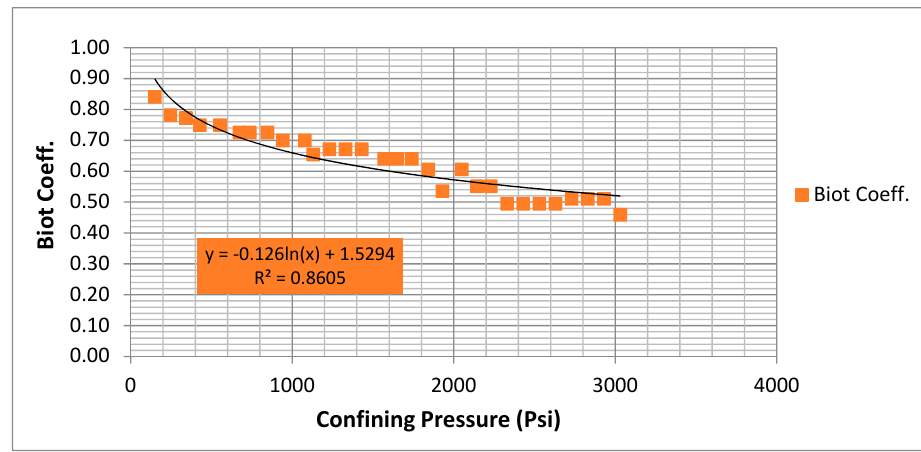
Figure 17. Biot coefficient vs. confining pressure for H5.